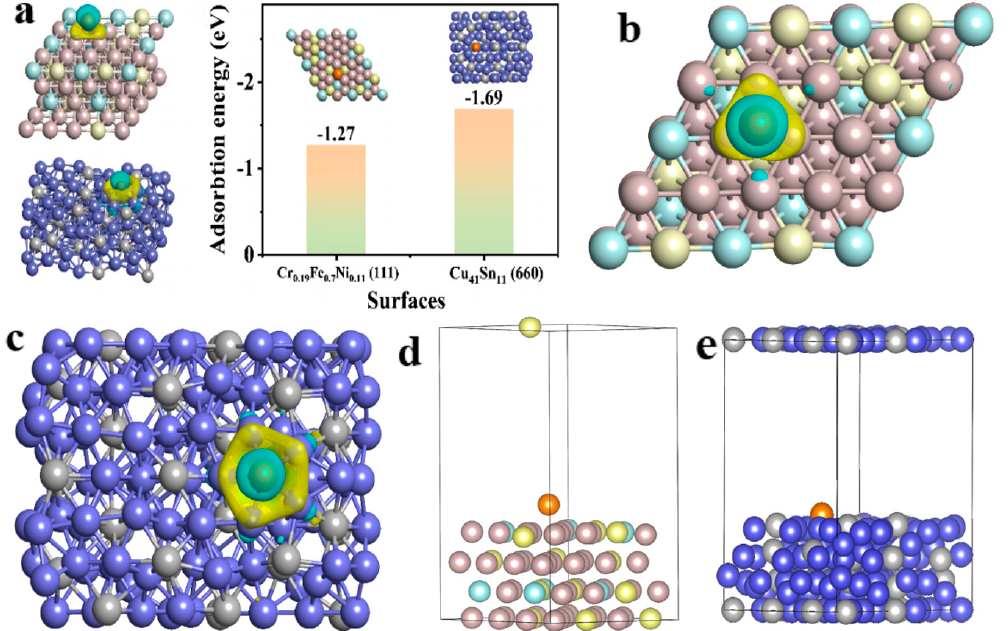
Figure 7. ( a ) The calculated di ff erential charge density and adsorption energy of Zn 2+ , Cu 41 Sn 11 (660), and Cr 0.19 Fe 0.7 Ni 0.11 (111), in which yellow and cyan surfaces correspond to the charge gain and loss regions, respectively. The adsorption energy between the Zn atom and Cu 41 Sn 11 (660) or Cr 0.19 Fe 0.7 Ni 0.11 (111). The calculated di ff erential charge density of Zn 2+ on ( b ) Cr 0.19 Fe 0.7 Ni 0.11 (111) and ( c ) Cu 41 Sn 11 (660), in which yellow and cyan surfaces correspond to the charge gain and loss regions, respectively. The calculation models of Zn adsorbed on ( d ) Cr 0.19 Fe 0.7 Ni 0.11 (111) and ( e ) Cu 41 Sn 11 (660). Reproduced with permission [81]. Copyright 2022 Elsevier B.V.